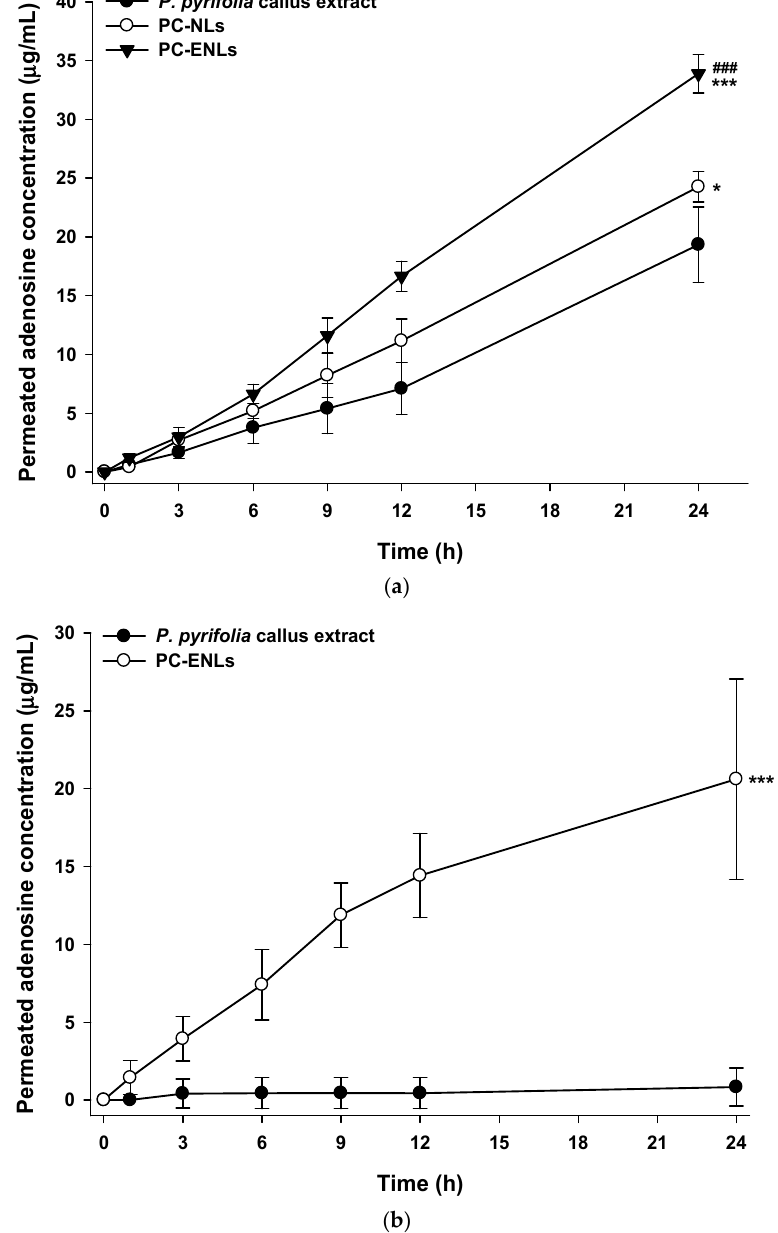
Figure 9. In vitro permeation of P. pyrifolia callus extract-loaded nanoliposomes (NLs) across artificial skin (Skin PAMPA) and human epidermal layer. Time course of changes in cumulative permeated concentrations of adenosine from the aqueous solution of callus extract or callus extract-loaded NLs (PC-NLs) or elastic NLs (PC-ENLs) through ( a ) Skin PAMPA and ( b ) human epidermis. Values are means ± standard deviation ( n = 6 per group). * p < 0.05, *** p < 0.001 compared to P. pyrifolia callus extract. ### p < 0.001 compared to PC-NLs.